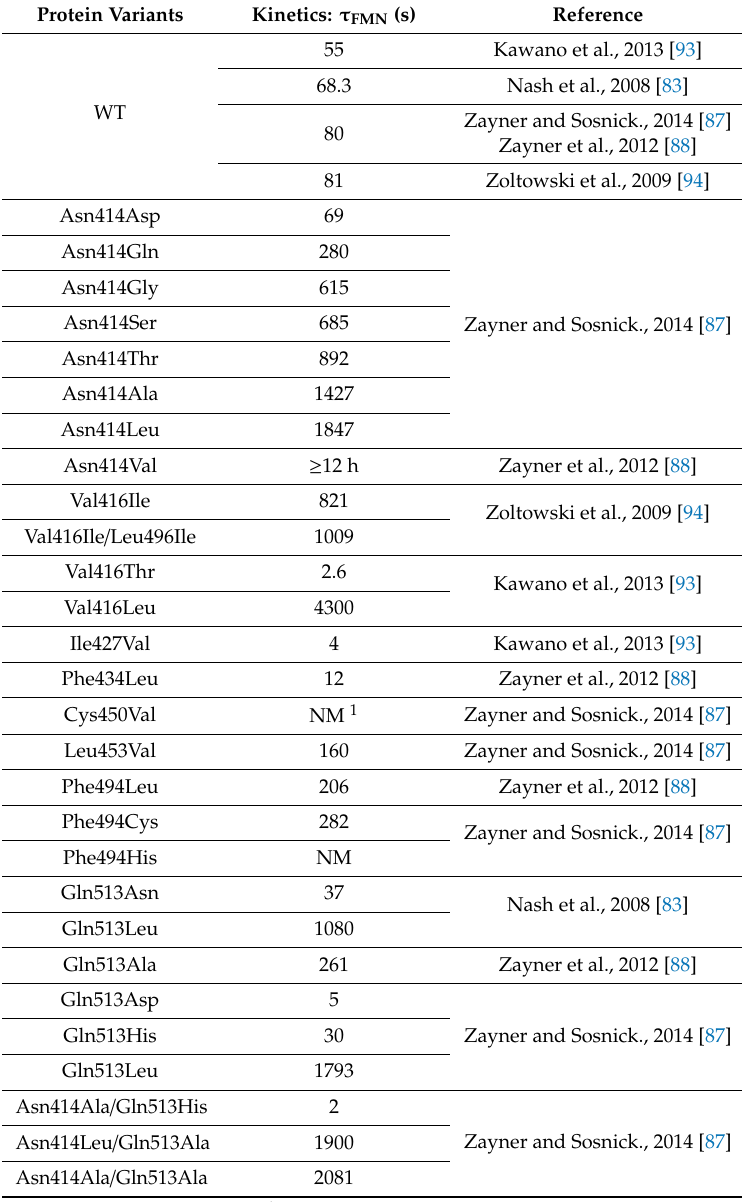
Table 1. Dark recovery kinetics of AsLOV2